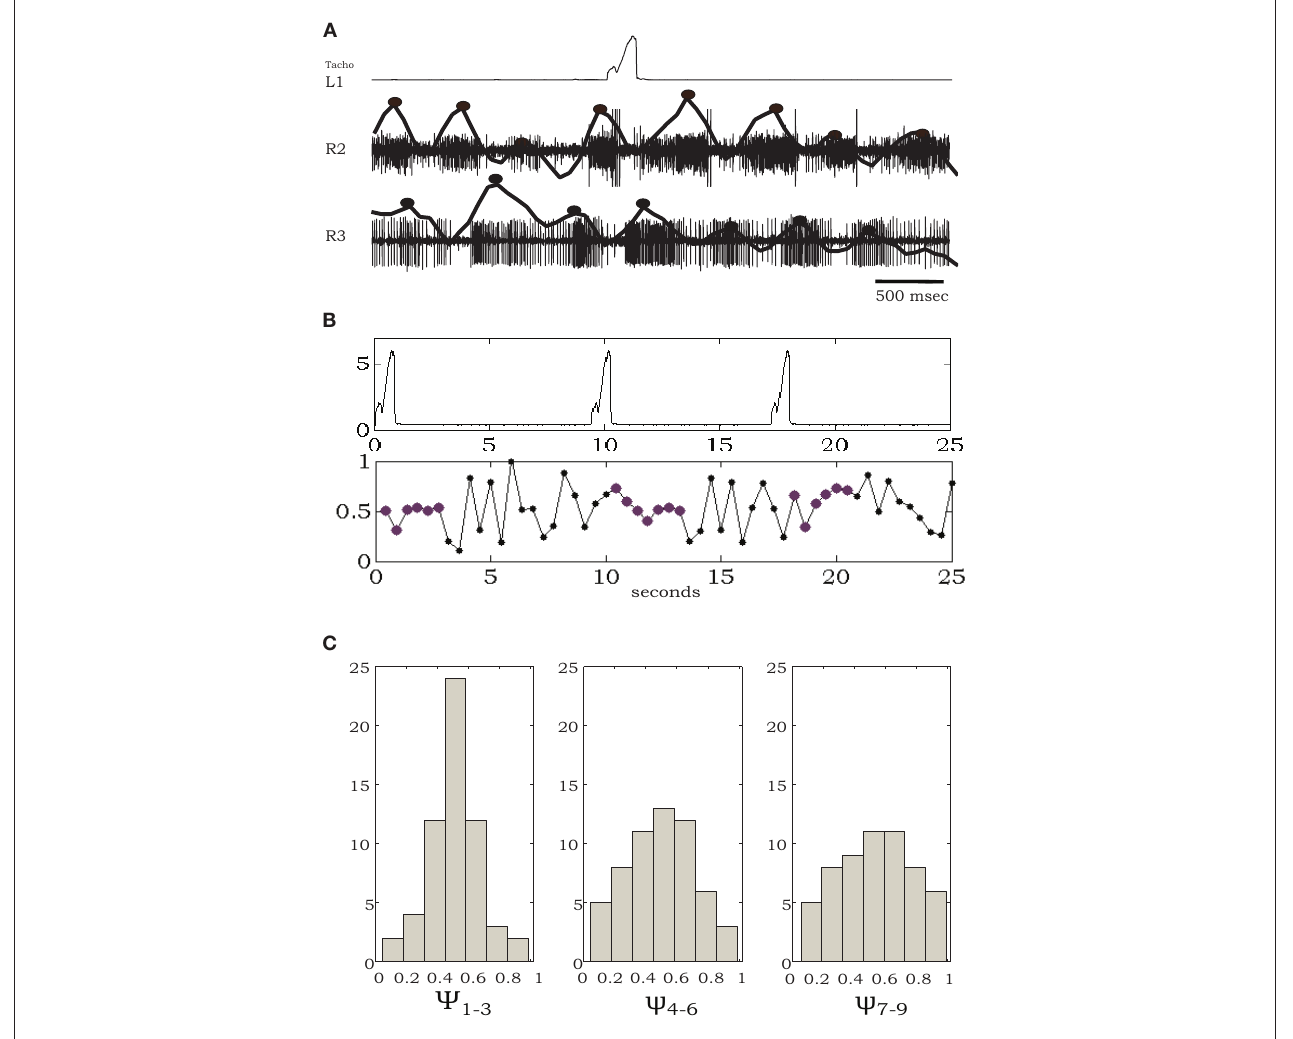
several cycles after each individual step. (C) Histograms of phase differences, obtained from four experiments, each containing 4–5 steps, and the following nine burst cycles divided into the first, second, and third sets of three cycles after each step (see text for details). The relatively narrow distribution around phase 0.5 in ψ broadens in ψ and ψ as time elapsed after each 1–3 4–6 7–9 step